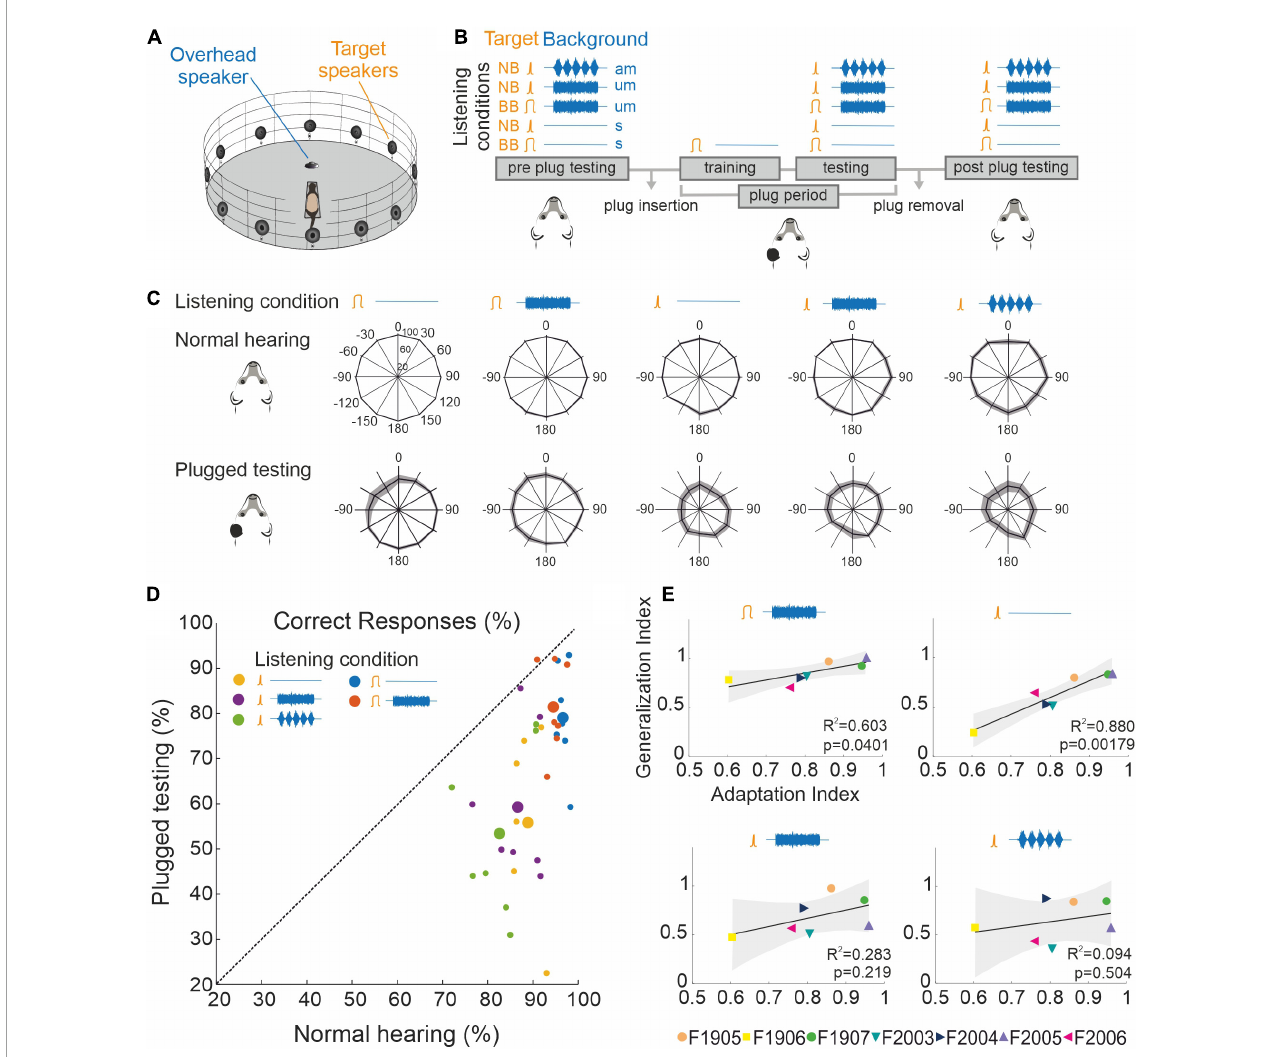
FIGURE7 Generalization of training-dependent adaptation. (A) Schematic of the circular testing arena indicating the position of the peripheral target loudspeakers (as in Figure 1 ) and the loudspeaker located above the central platform used to generate background noise. (B) Timeline indicating the different combinations of target and background sounds used for behavioral training and testing. The two types of target sounds [broadband (BB) and narrowband (NB) noise] are depicted in orange and three possible backgrounds [silence (s), unmodulated BB noise (um), and BB noise amplitude modulated at 5 Hz (am)] are shown in blue. (C) Spatial distribution of mean ( ± S.E.) percent correct scores for each target and background combination under normal listening conditions (top row) and after adaptation to an earplug in the left ear (bottom row). (D) Mean percent correct scores for all target and background combinations under normal hearing conditions and after adaptation with one ear plugged. Large circles are the mean values and the small circles represent individual animals. Almost all values fall below the diagonal identity line, indicating more accurate responses with normal binaural inputs. Responses to BB targets were closer to the identity line and therefore showed less difference between the two hearing conditions. (E) Relationship between the adaptation index (the ratio of the percent correct scores for BB noise in silence in the final 3 days of adaptation to monaural occlusion and the preplug scores) and the generalization index [the ratio of the percent correct scores for each of the other stimulus types (shown at the top of the panels) measured with the earplug in place at the end of the adaptation run and the corresponding preplug